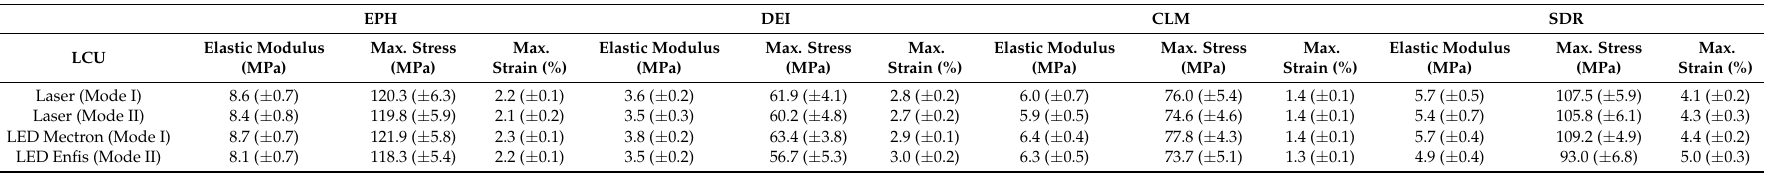
Table 4. Mechanical properties of restorative composites after 7 days since curing, according to light source and curing mode. All the results are reported in terms of mean values and standard deviation (in